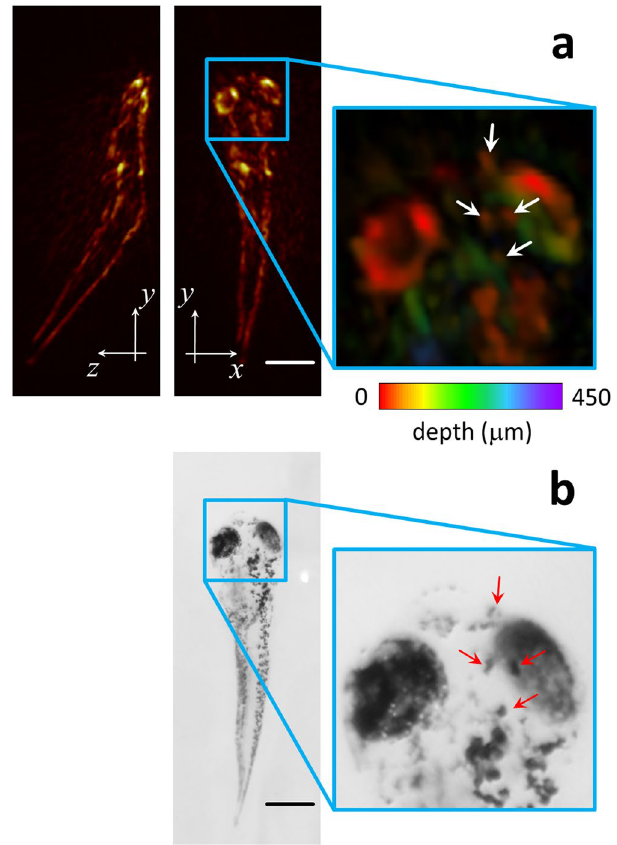
Figure 3. Images of a 6-dpf zebrafish larva post mortem . ( a ) Maximum intensity projections of the 3D optoacoustic image ( b ). Corresponding bright field optical microscopy image. Scalebar – 0.5 mm.